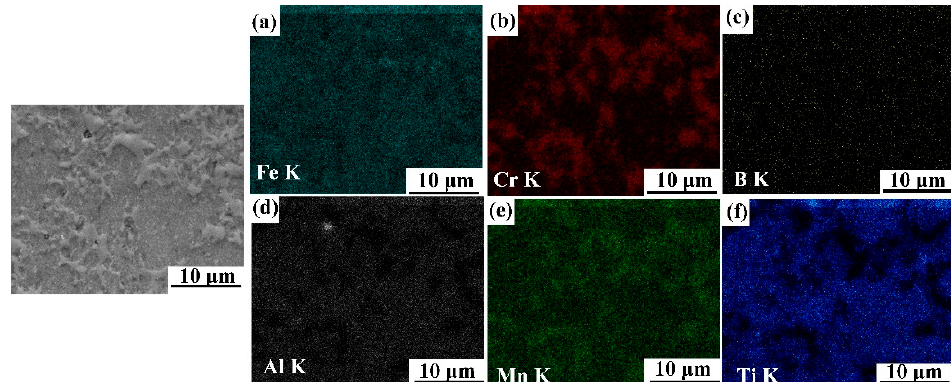
Figure 4. SEM image of 20 vol.%TiB 2 /Fe-15Cr-10Mn-5Al composite and elemental maps showing the distribution of ( a ) Fe, ( b ) Cr, ( c ) B, ( d ) Al, ( e ) Mn, and ( f ) Ti.